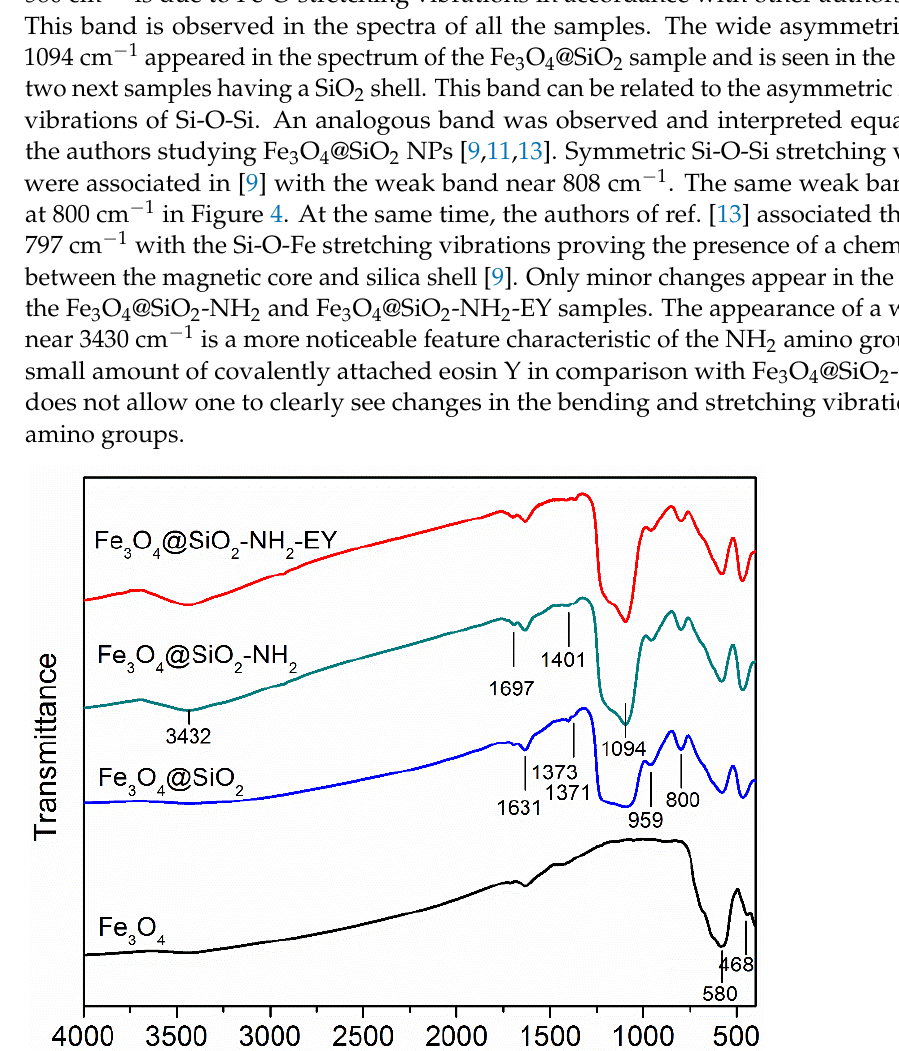
Figure 3. HRTEM image and selected area electron diffraction (SAED) of Fe 3 O 4 ( a , b ) and Fe 3 O 4 @SiO 2 -NH 2 ( c , d ) NPs, respectively.